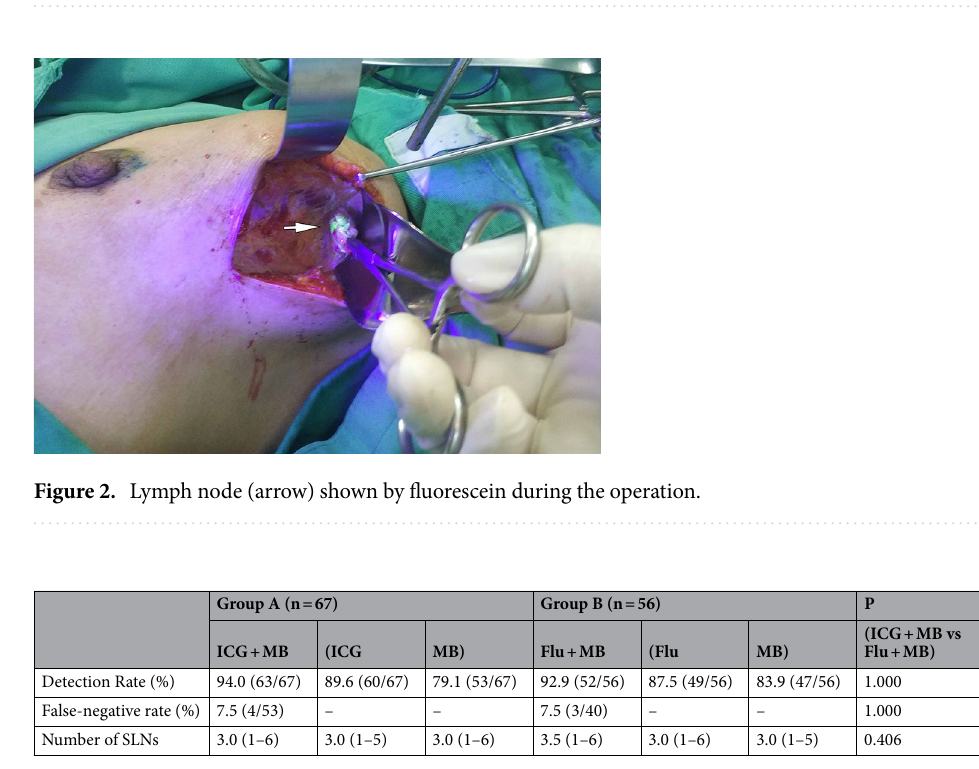
Figure 1. Lymph vessel (arrow) shown by fluorescein during the operation.